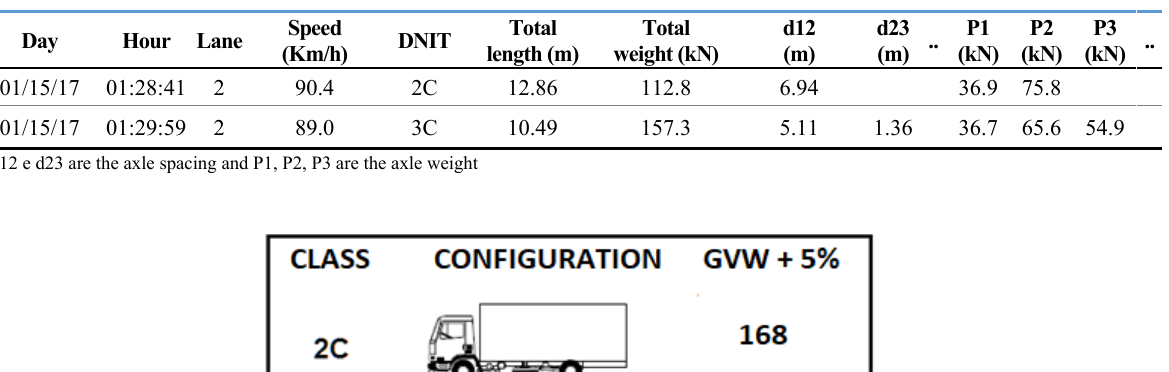
Table 1. WIM data in the spreadsheets.